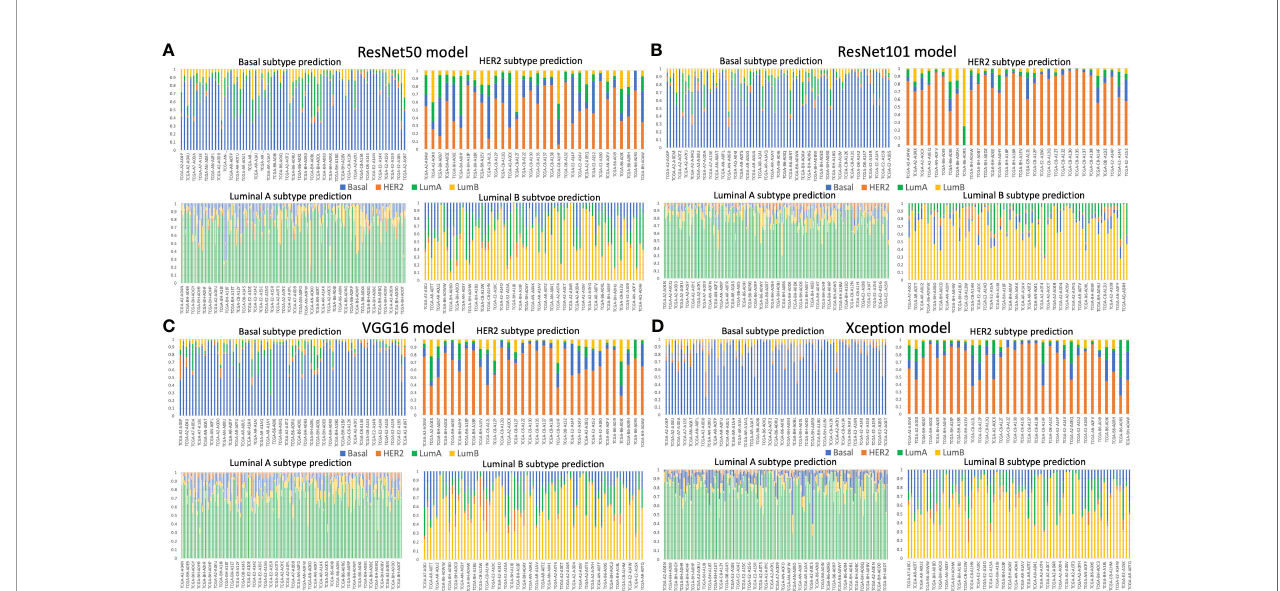
FIGURE 4 | Slide-wise subtype prediction using the testing set. (A) ResNet50 model, (B) ResNet101 model, (C) VGG16 model, (D) Xception model. Basal, HER2, luminal A, and luminal B subtypes are represented in blue, orange, green, and yellow bars, respectively. A threshold of 0.5 was used to select the correct prediction subtype from the whole slide image of each patient. The prediction probability of each subtype was aggregated from the patches of the same patient.